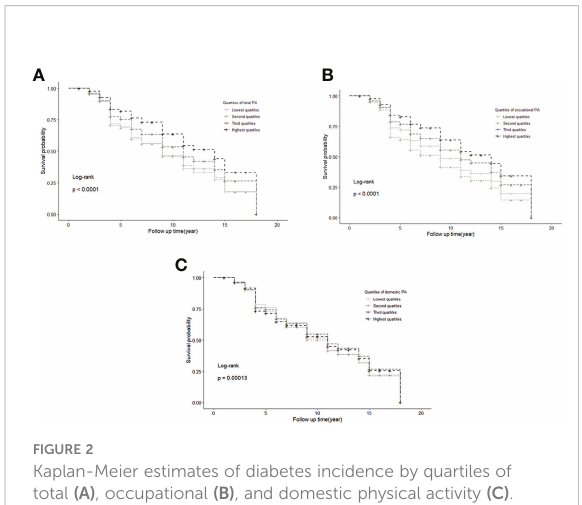
FIGURE 2 Kaplan-Meier estimates of diabetes incidence by quartiles of total (A) , occupational (B) , and domestic physical activity (C) . Notion: PA, physical